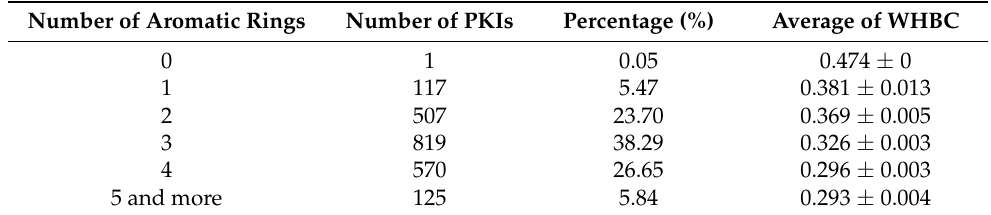
Table 3. Distribution and the average value of the weighted hydrogen bond count (WHBC) for each class of protein kinase inhibitor